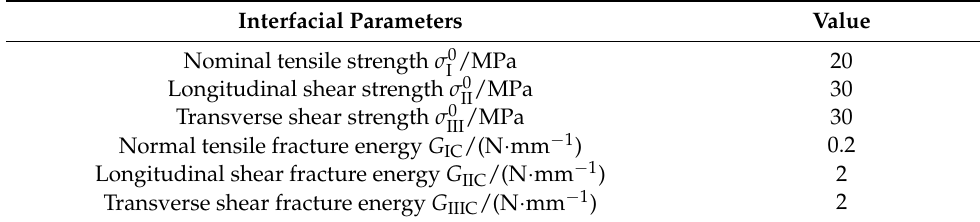
Table 3. Interfacial parameters of cohesive